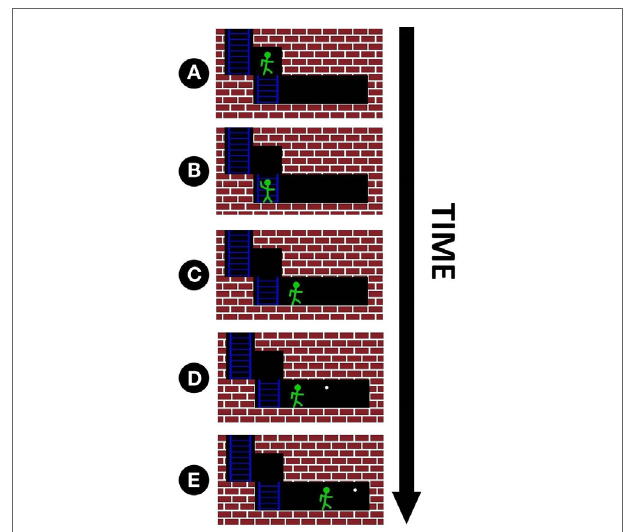
FigUre 6 | For each maze, the subject has ten opportunities for movement . An example of four hypothetical movements is shown above. Note that the maze is not visible to the subject until the end of the trial, and all movement decisions must be made based only on TMS pulses. (a) The avatar is directly in front of a wall, thus triggering an above-threshold TMS pulse. The subject identifies this pulse correctly and makes a discrete movement down to the location shown in (B) . (B) Since no wall is in front of the avatar, a subthreshold pulse is triggered. The subject correctly identifies this pulse and advances to the location shown in (c) . (c) No wall directly in front corresponds to another subthreshold pulse. This time, the subject misidentifies the pulse and does not advance. (D) The white dot marks the location the avatar would have occupied if the subject had answered with 100% accuracy for the duration of current game (the white dot only marks this optimal location and has no influence on pulse intensity). As there is still no wall directly in front of the avatar, a subthreshold pulse is fired again. The subject correctly identifies that no obstacle is directly in the avatar’s path and advances one space forward. (e) This marks the end of the game. At this point, the maze is displayed on the subject’s screen to provide feedback on how far they progressed through the maze. Note that whenever the subject views the screen, either the avatar or the white dot will occupy the last location in the maze, corresponding to completing or not completing the maze,